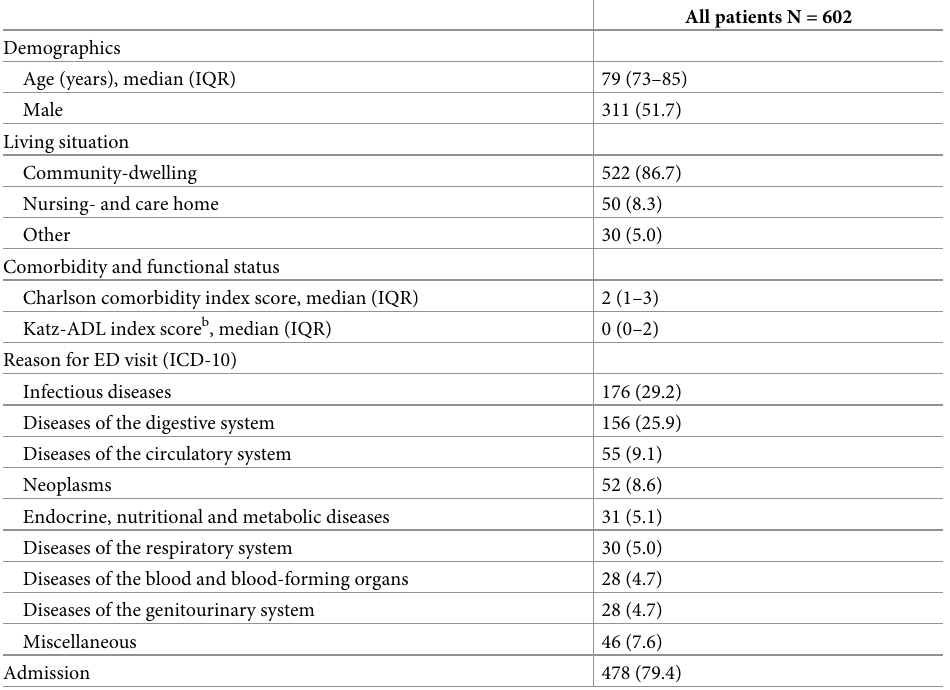
Table 1. Characteristics of patients and professionals a